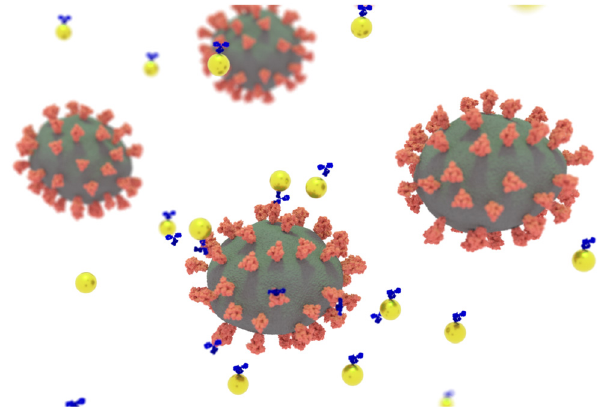
Figure 1: The virion (green) with red spikes, gold nanoparticles (gold) andtheantibodiesagainstSevereAcuteRespiratorySyndrome-Corona Virus-2 (SARS-CoV-2) (blue). The virion is approximately 100 nm in diameter, the gold nanoparticles are about 40 nm in diameter, and the antibodies are about 10 nm in diameter,